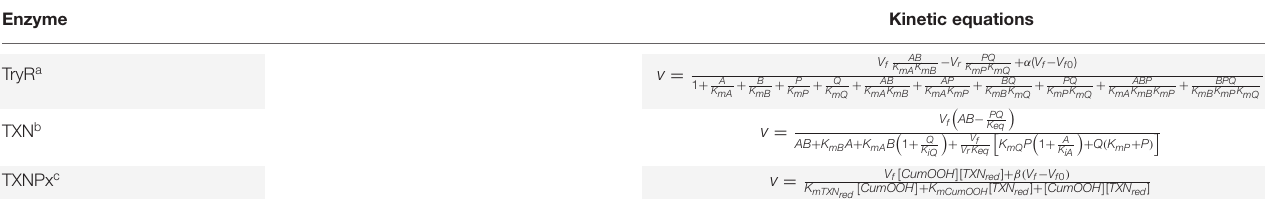
TABLE 1 | Kinetic equations used in the gray-box model of the peroxide detoxification pathway (González-Chávez et al., 2015). Enzyme Kinetic